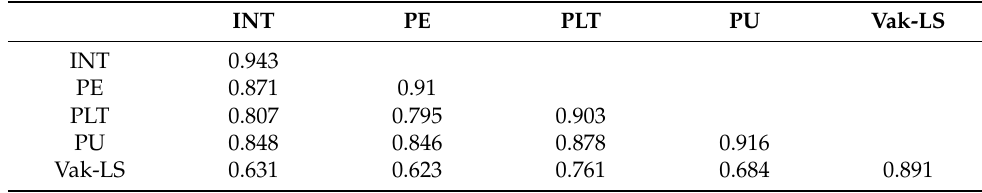
Table 4. Fornell-Larcker criterion.